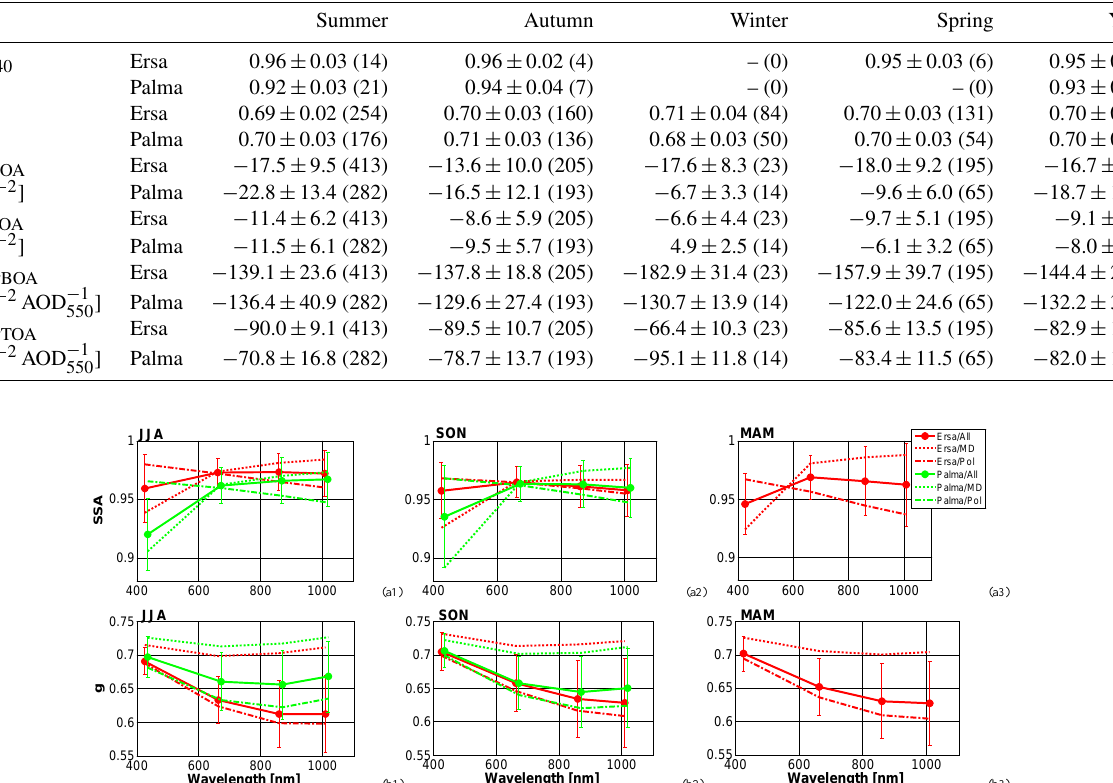
Table 3. Seasonal and annual variations of the following aerosol properties with their standard deviation (and number of observations in parenthesis): single scattering albedo at 440nm (SSA 440 ) , asymmetry factor at 440nm ( g 440 ) , the solar aerosol radiative forcing (ARF) and the solar aerosol radiative forcing efficiency (ARFE) at Ersa and Palma derived from AERONET level 2.0 daily inversion products available for the period 2011–2015. BOA and TOA stand for bottom of the atmosphere and top of the atmosphere, respectively. The values of SSA 440 are given for 50<solar zenith angle (SZA)<80 ◦ and an aerosol optical depth at 440nm (AOD 440 ) >0.40. The values of ARF and ARFE are given for 50<SZA< 60 ◦ .